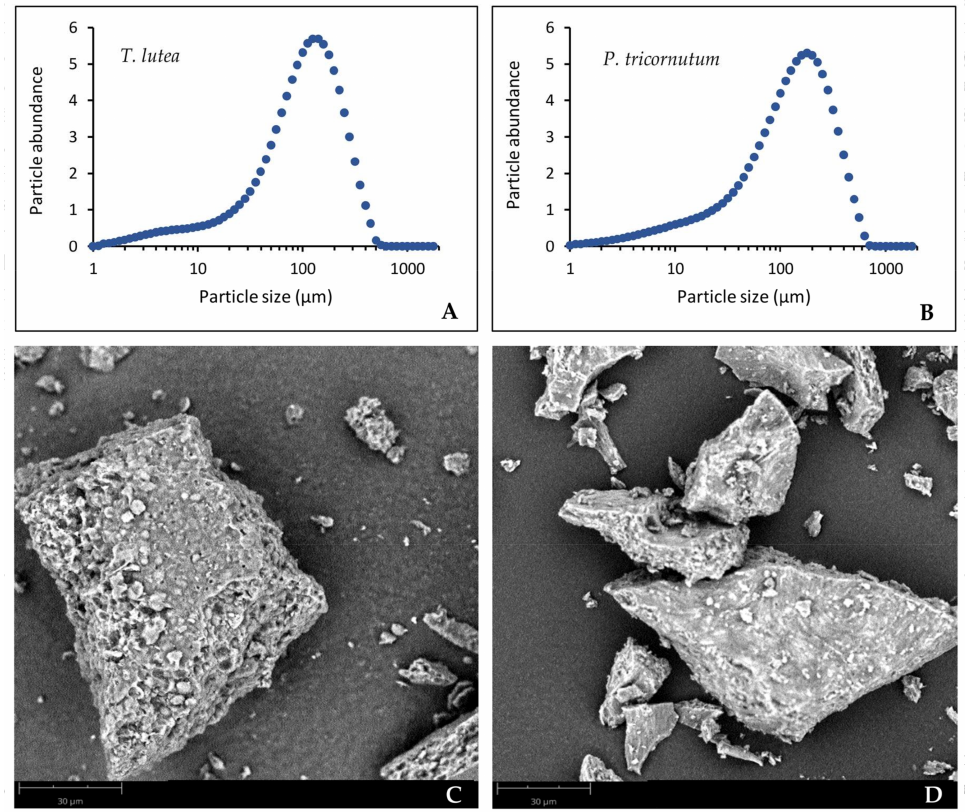
Figure 2. Determination of particle size distribution (graphs) and scanning electron microscope observations at 30 µ m scale of freeze-dried biomasses of Tisochrysis lutea ( A , C ) and Phaeodactylum tricornutum ( B , D ) crushed with mortar and